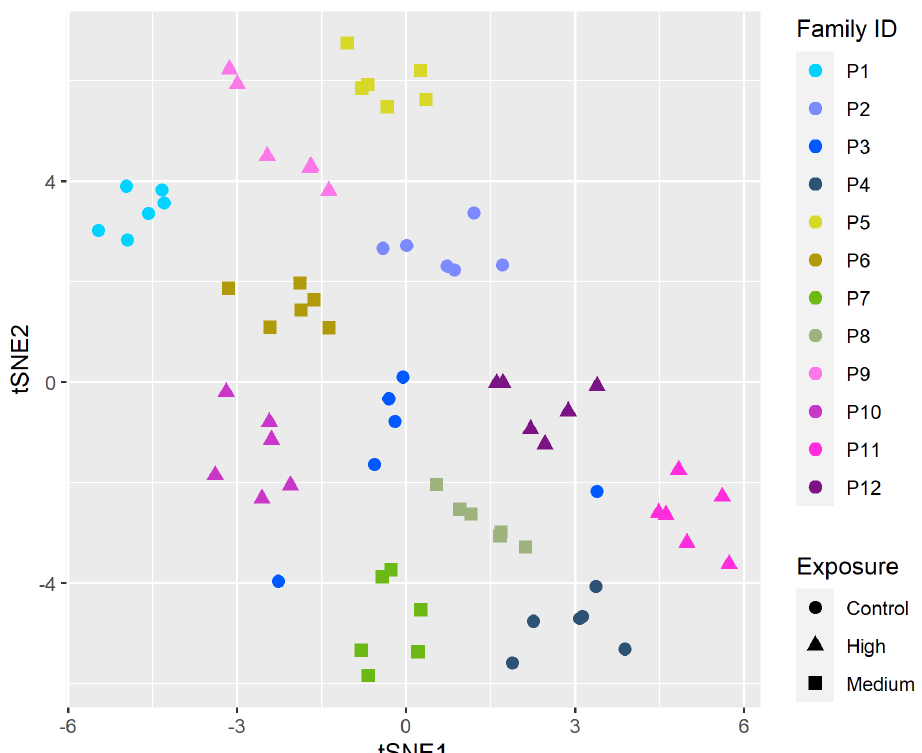
Figure 3. tSNE of normalized gene expression counts of genes that had a significant GxE effect. Color of the points represent family and shape represents exposure. Shades of blue are controls; shades of green represent medium PFHxA groups, and shades of pink represent high PFHxA groups.